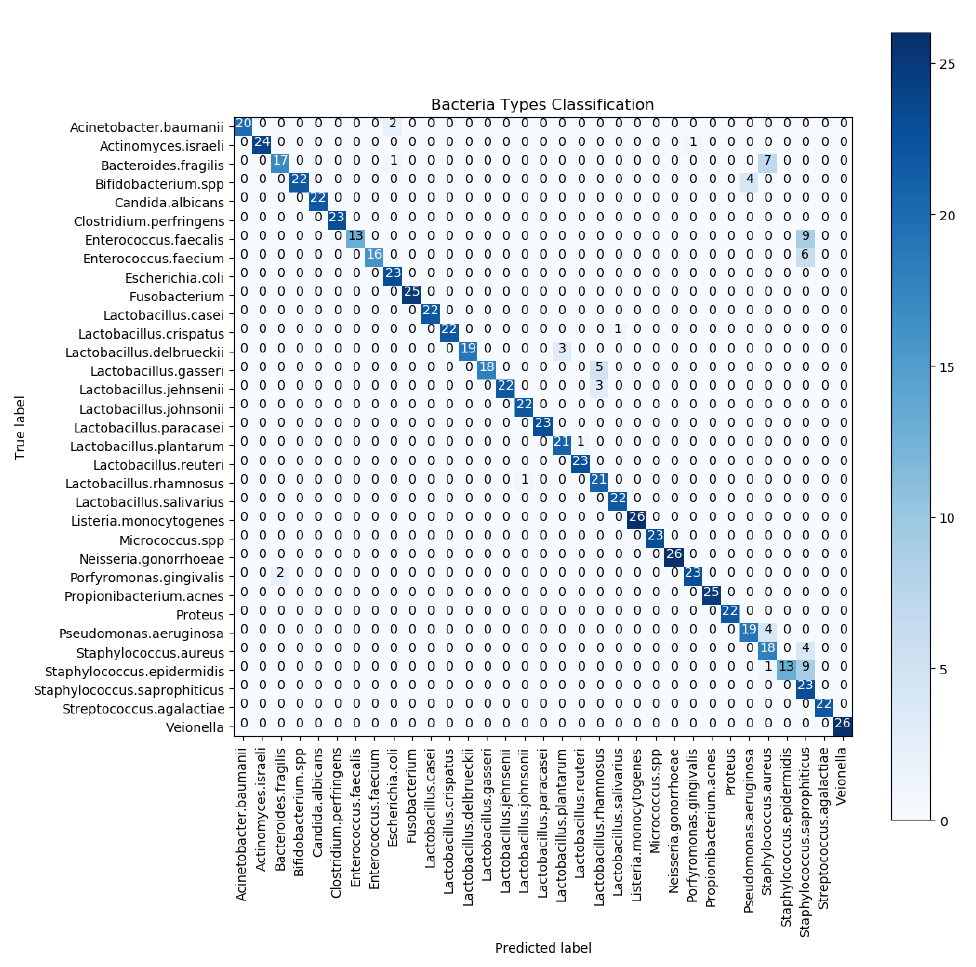
Figure 8. Bacteria classification confusion matrix using 5-fold cross-validation.